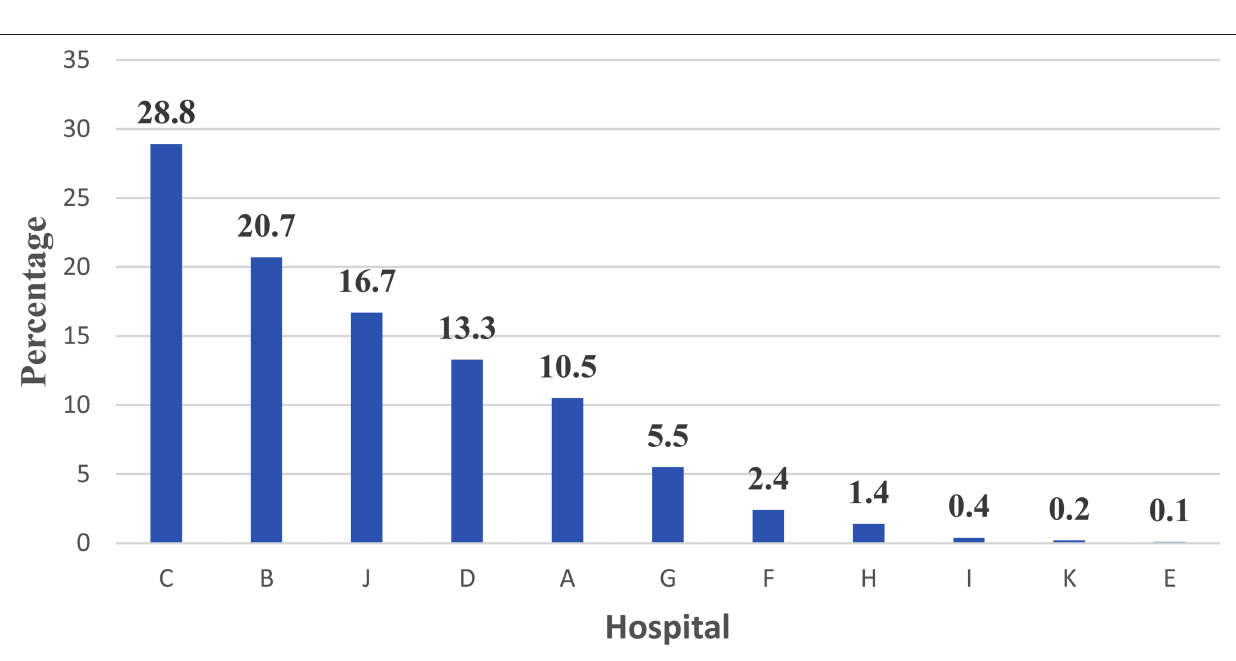
the current study, a higher percentage of medical staff 27.9%